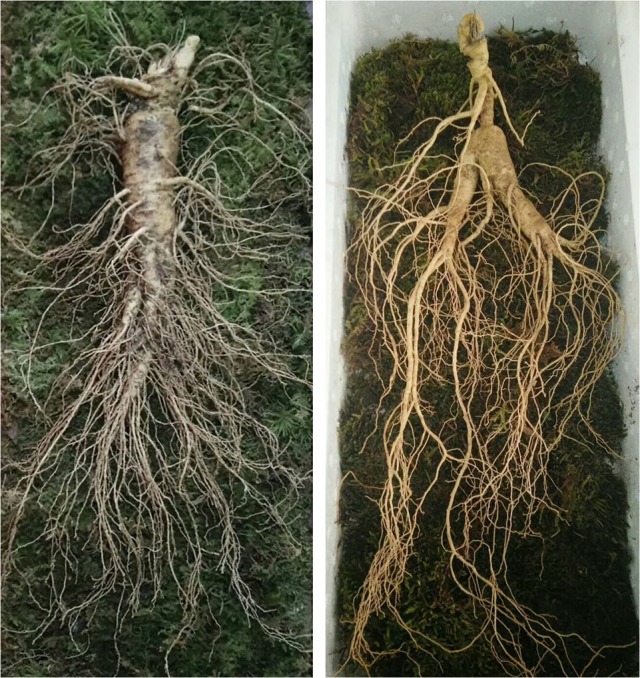
Root of Ginseng.